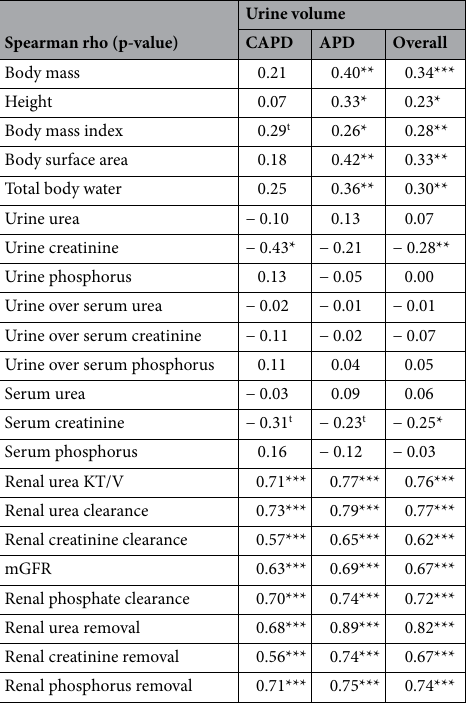
Table 3. Correlations between urine volume and other parameters in patients on continuous ambulatory (CAPD), automated peritoneal dialysis (APD) and for pooled data. ***, **, *, t denote p value < 0.001, < 0.01, < 0.05 and < 0.10, respectively.